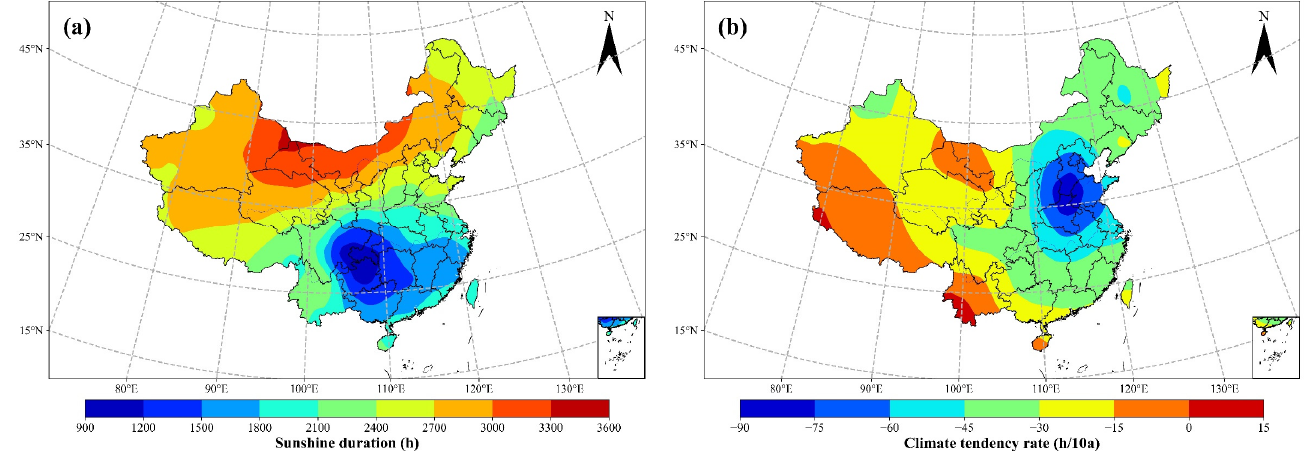
Figure 5. Spatial distribution of SD ( a ) and climate tendency rate ( b ) in China.